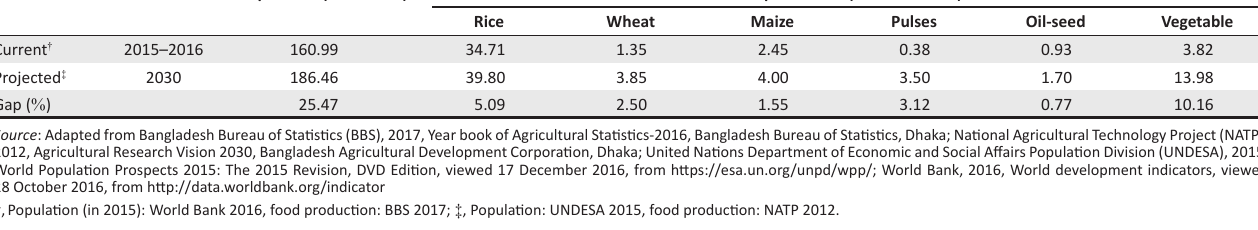
TABLE 3: Current food production (in million ton) and projected food requirement by 2030.